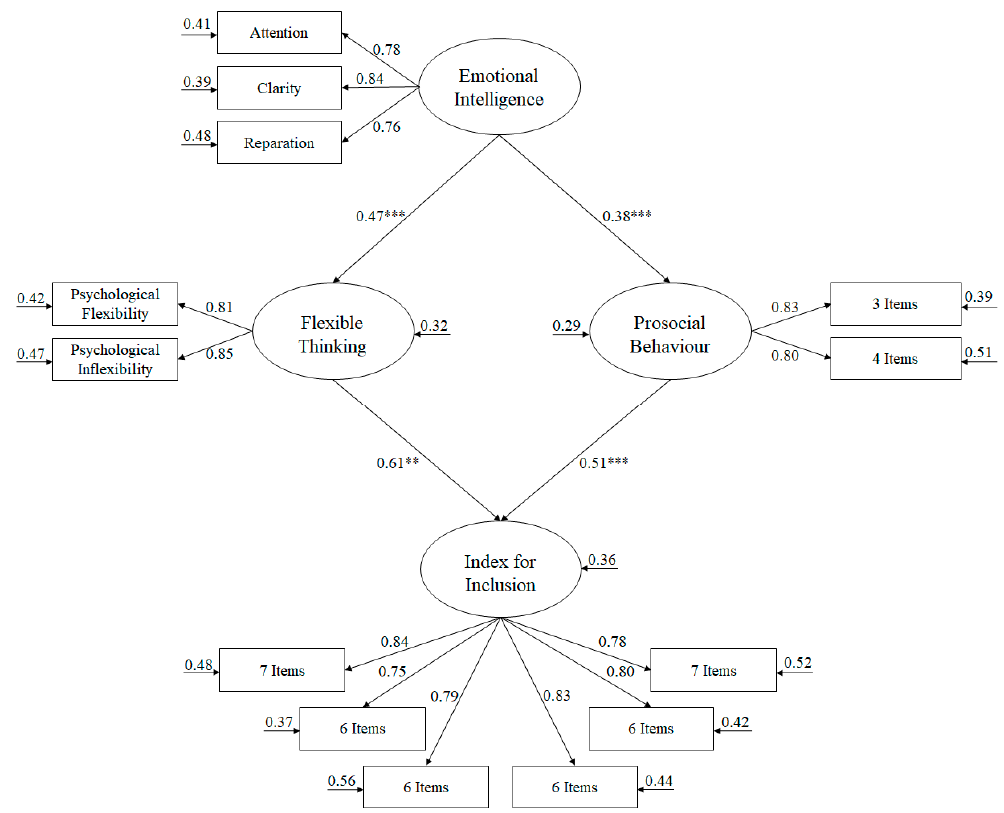
Figure 1. Structural equation model, showing all parameters and being statistically significant. Note: *** p < 0.001; ** p < 0.01.